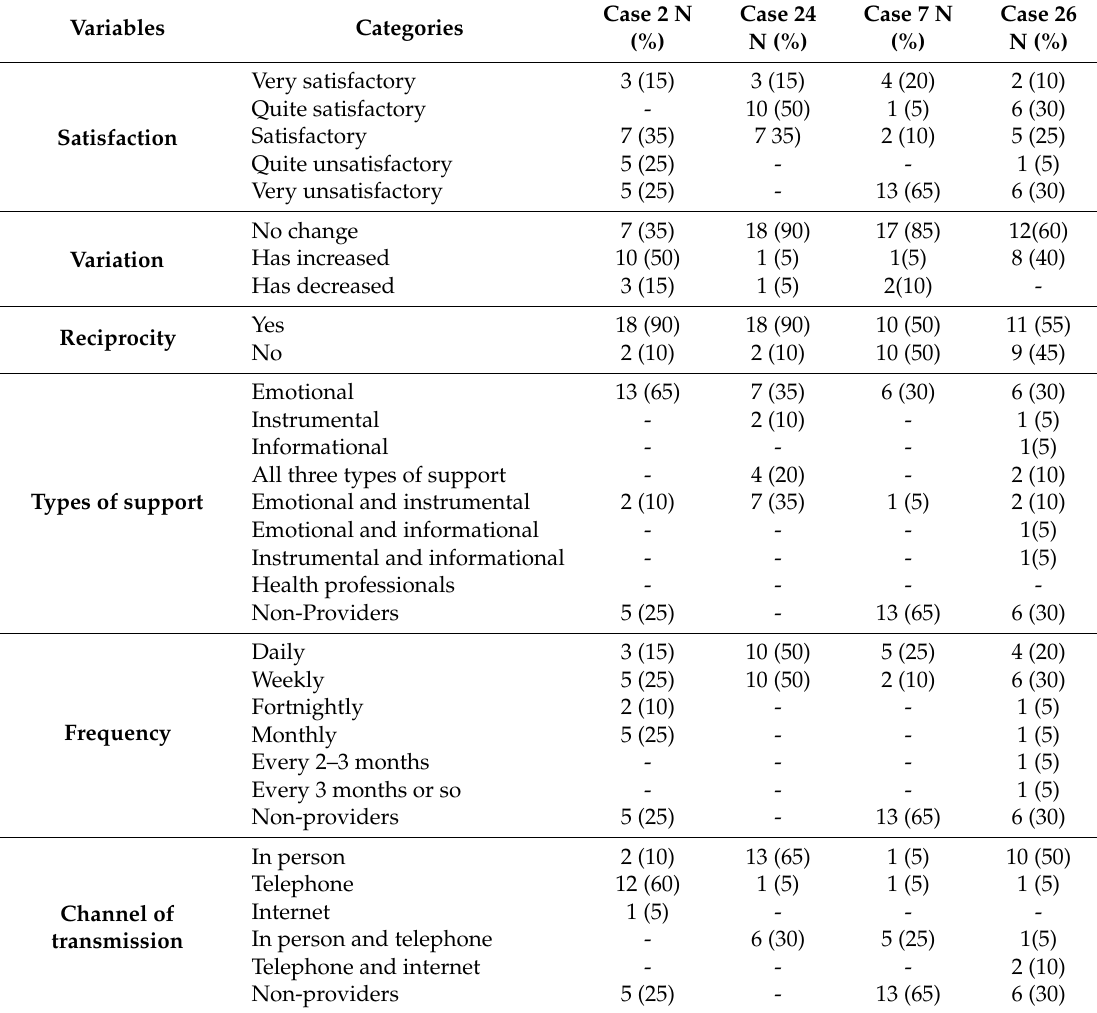
Table 5. Descriptive analysis of social support at ego level.